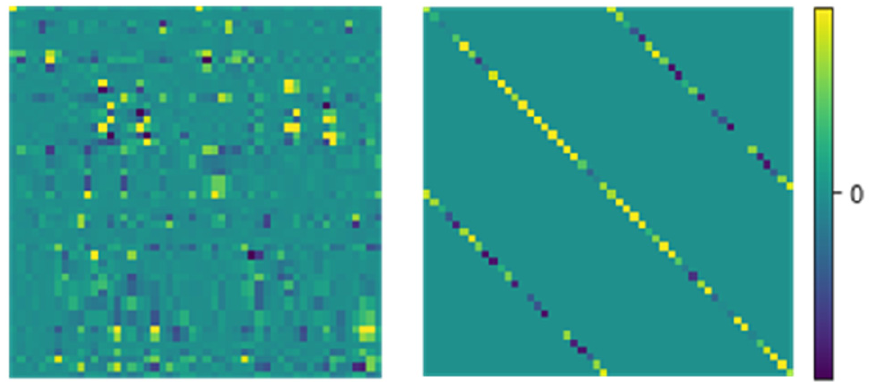
Figure 2. Example of the matrix form in the computation of local s-matrices in the RCWA method. On the left is a completed matrix form involved in grating layers. On the right is the special form composed of four sub-diagonal matrices, which is applied to enhance the RCWA simulation of homogeneous layers.